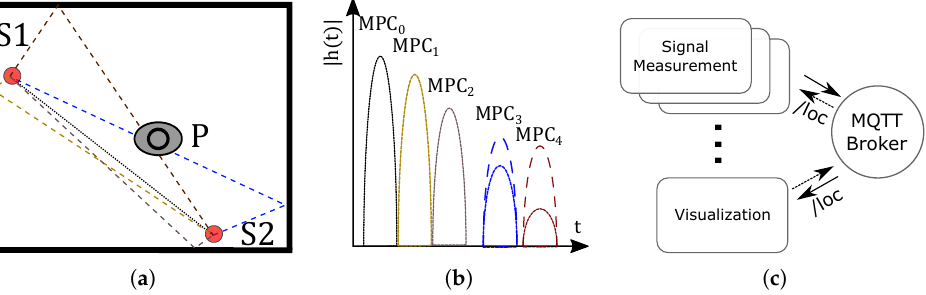
Figure 1. Principle of the proposed MA DFL System and an excerpt from the system view. ( a ) Map information with MPCs. ( b ) Resulting UWB CIRs. ( c ) Modular